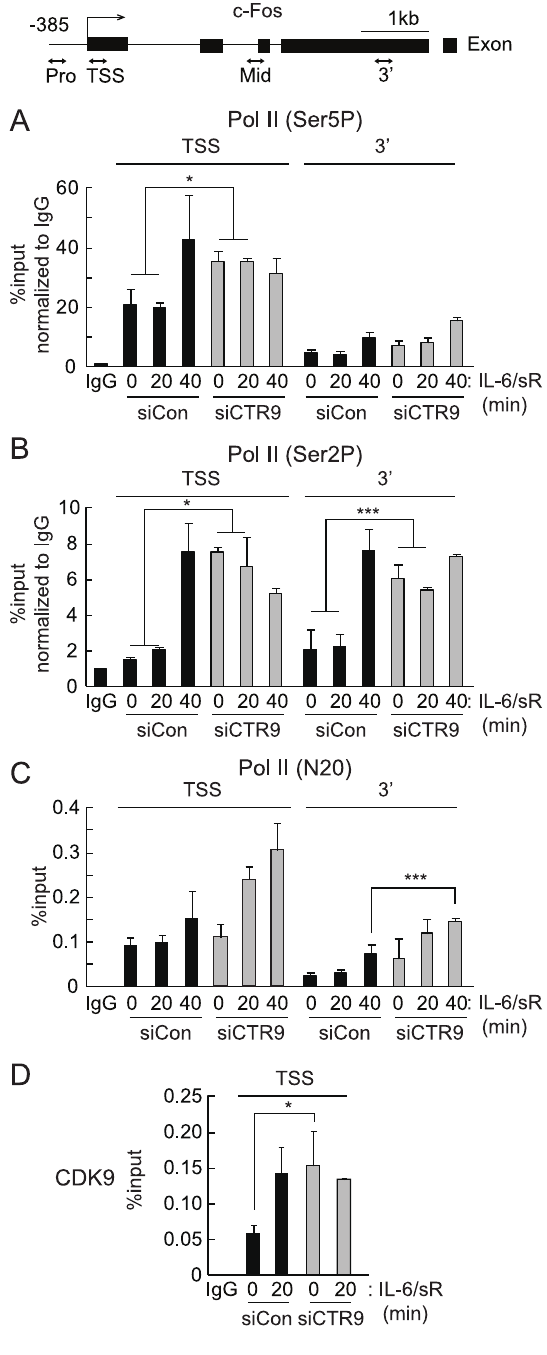
Figure 2. Elongating RNA Pol II pre-occupies the c-Fos locus in the CTR9-deficient cells. Top, diagram of the c-Fos genomic loci. Every PCR primers used for ChIP analyses in this study are shown as two-sided arrows. HepG2 cells were transfected with control siRNAs or CTR9 siRNAs and treated with IL-6 plus IL-6sR (20 ng/ml each) for the indicated length of time. ChIP analyses were performed with soluble chromatin using antibodies as indicated: anti-Ser5P CTD ( A ), anti-Ser2P CTD ( B ), anti-RNA polymerase II N-terminus ( C ), and anti-CDK9 ( D ),. Bound DNA was analyzed by quantitative PCR using primers specific to c-Fos loci. *p , 0.05, ***p , 0.001 by Student’s t test. Error bars represents SD (n=3).